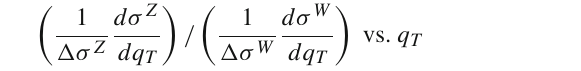
bands are referred to the average value of each bin (red